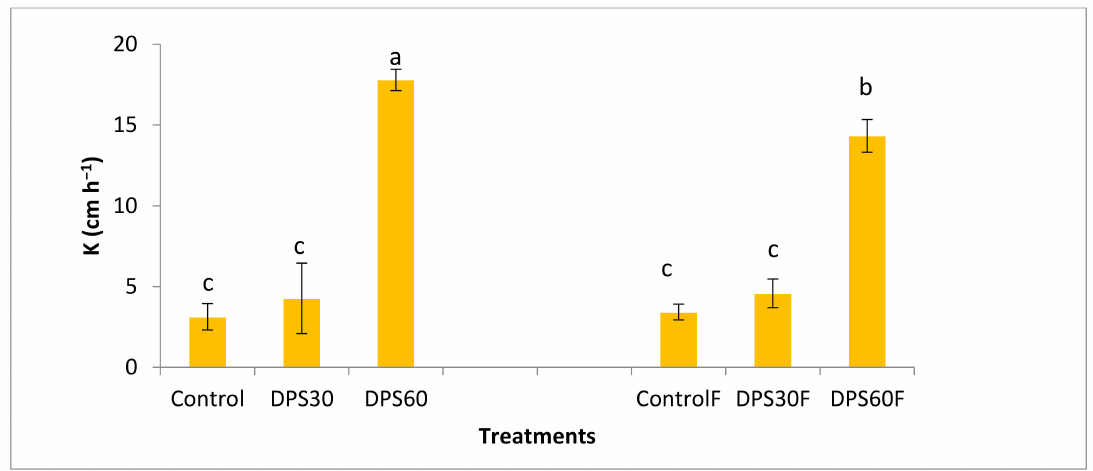
Figure 2. E ff ect of the application at di ff erent rates (0, 30, and 60 Mg ha − 1 ) of deinking paper sludge (DPS) on the permeability (K) of the calcareous soil (in the presence or absence of nitrogen fertilizer (ammonium nitrate at 150 kg ha − 1 )). Bars with di ff erent letters are statistically di ff erent at p < 0.001. Treatments: control, no DPS; DPS30, DPS at 30 Mg ha − 1 ; DPS60, DPS at 60 Mg ha − 1 ; controlF, control with fertilizer; DPS30F, DPS30 with fertilizer; DPS60F, DPS60 with